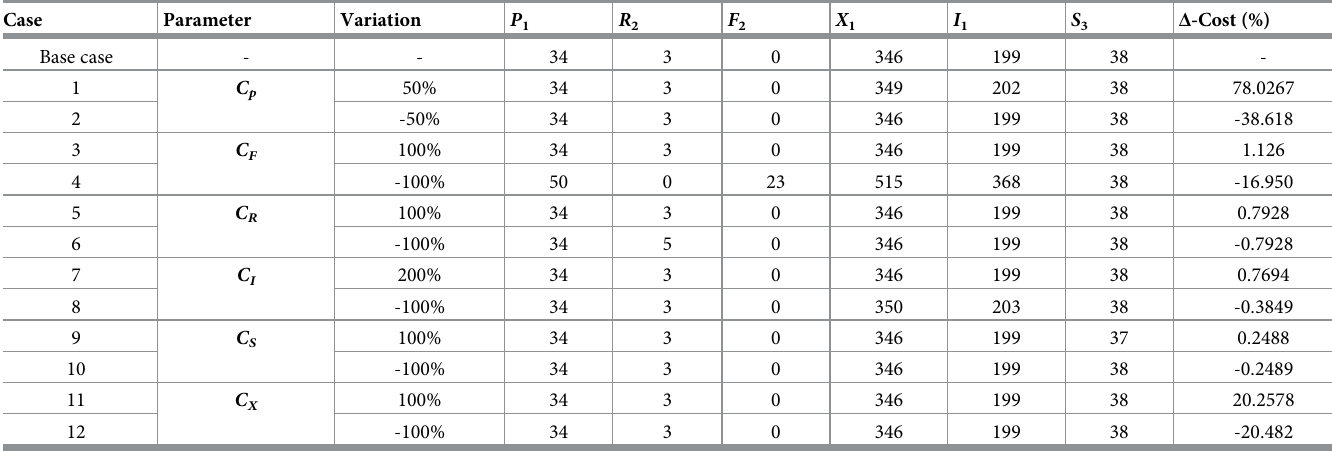
Table 9. Sensitivity analysis of Model-II. Own